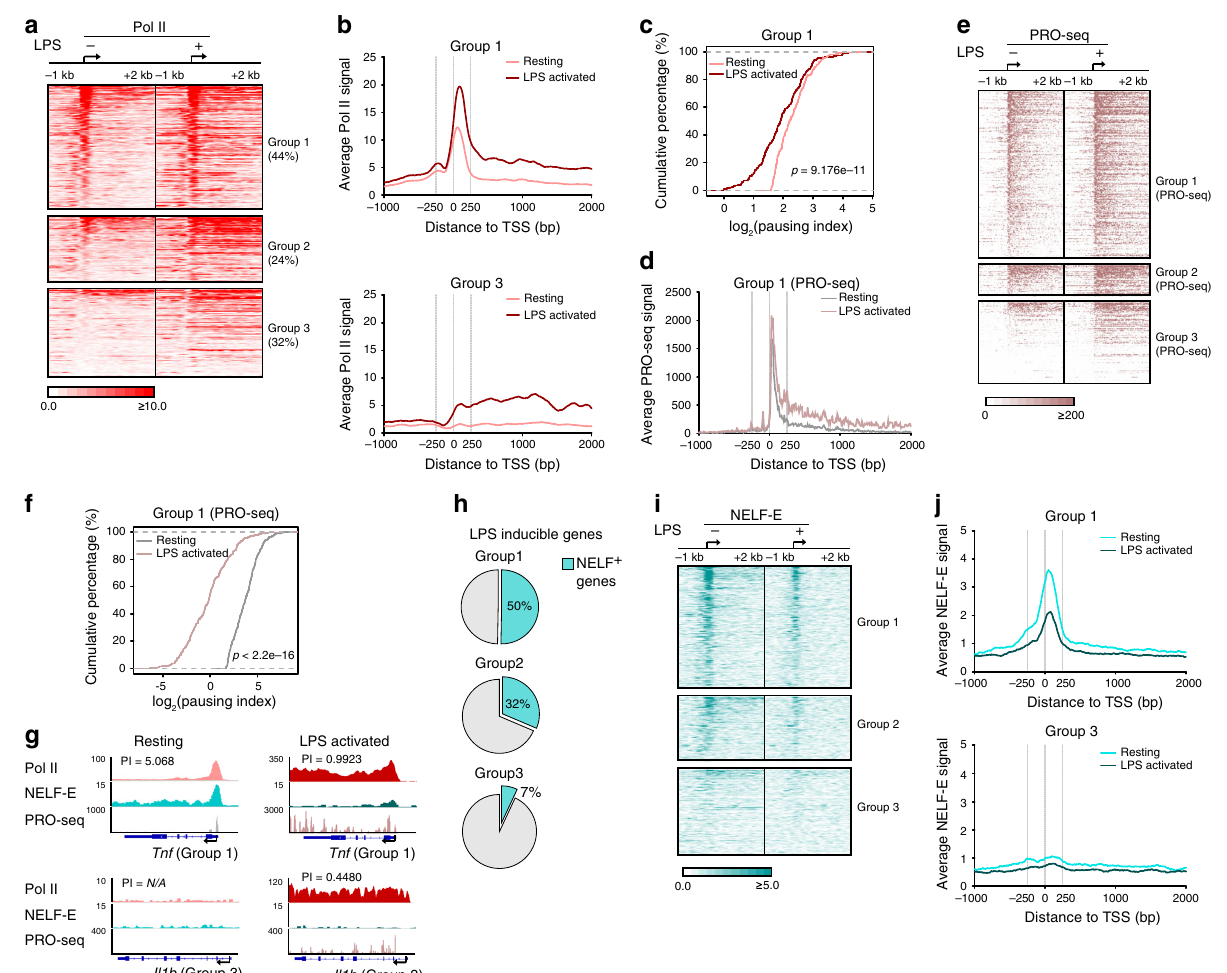
Fig. 3 Macrophage activation is associated with Pol II pause-release. a Heat map of Pol II ChIP-seq signals in resting and LPS-activated (1 h) BMDM around the TSS regions of group 1 – 3 LPS-inducible genes. For each group, the rows were sorted by the decreasing Pol II ChIP-seq signal in the TSS region in resting BMDM. b Average Pol II ChIP-seq signals in resting and LPS-activated BMDM around TSS of group 1 (top) and group 3 (bottom) LPS-inducible genes. ( c ) The empirical cumulative distribution function (ECDF) plot of Pol II PI distribution of group 1 LPS-inducible genes in resting and LPS-activated BMDM. p Value (resting/LPS activated p = 9.176e − 11 ) was calculated by two-sided Kolmogorov – Smirnov test. d Average PRO-seq signals (sense strand) in resting and LPS-activated BMDM around TSS of PRO-seq group 1 LPS-inducible genes. e Heat map of PRO-seq signals (sense strand) in resting and LPS- activated (0.5 h) BMDM around the TSS regions of group 1 – 3 LPS-inducible genes that were classi fi ed by PRO-seq de fi ned PI. For each group, the rows were sorted by decreasing PRO-seq signals (sense strand) in TSS regions. f The empirical cumulative distribution function (ECDF) plot of PRO-seq-de fi ned PI of group 1 LPS-inducible genes in resting and LPS-activated (0.5 h) BMDM. p Value (resting/LPS activated P < 2.2e − 16 ) was calculated by two-sided Kolmogorov – Smirnov test. g Tracks of Pol II ChIP-seq, NELF-E ChIP-seq, and PRO-seq (sense strand), as indicated, are shown for representative group 1 ( Tnf ) and group 3 ( Il1b ) genes in resting (left) and LPS-activated (right) BMDM. h The percentage of NELF + genes in group 1 – 3 of LPS-inducible genes. i Heat map of NELF-E ChIP-seq signals in resting and LPS-activated (0.5 h) BMDM around the TSS regions of group 1 – 3 LPS-inducible genes. For each group, the rows were sorted as in ( a ). j Average NELF-E ChIP-seq signals in resting and LPS-activated BMDM around TSS of group 1 (top) and group 3 (bottom) LPS-inducible